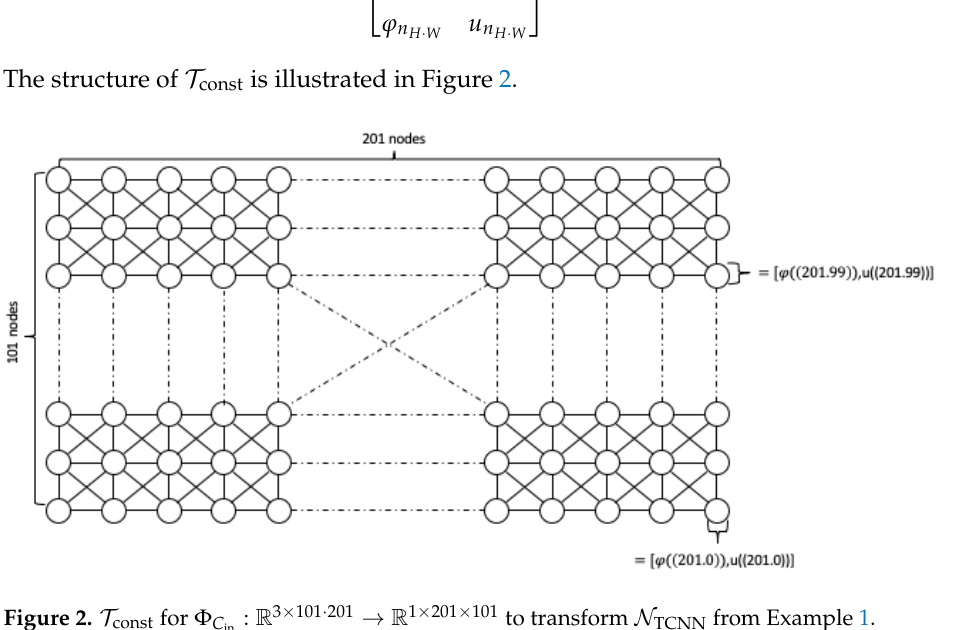
Figure 2. T const for Φ C : R 3 × 101 · 201 → R 1 × 201 × 101 to transform N TCNN from Example in